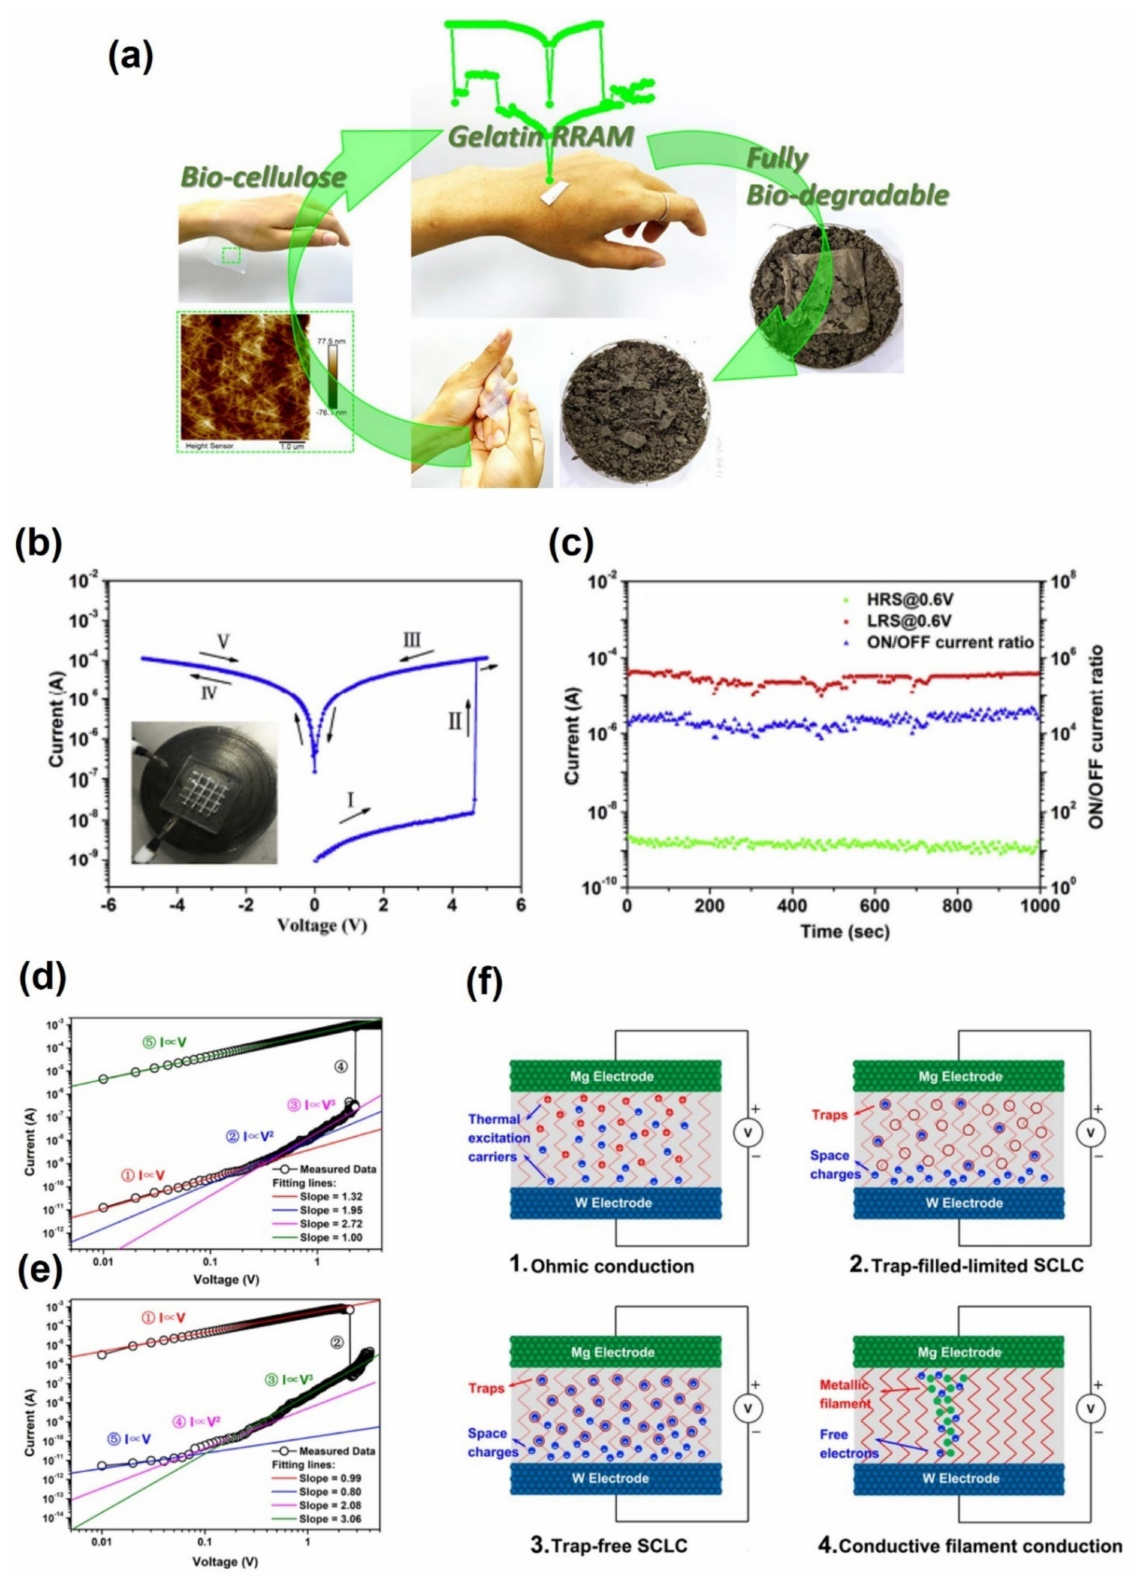
Figure 10. ( a ) Cellulose-based memory device that degrades in five days (adapted from [133] with permission from the American Chemical Society), ( b ) I–V curve of the resistive switching memory device and ( c ) retention and on/off ratio by time of the resistive switching memory device [132]. I–V curve of the space charge limited model according to process: ( d ) set process and ( e ) reset process [134]. Additionally, ( f ) the schematic of carrier distribution by biasing different voltage